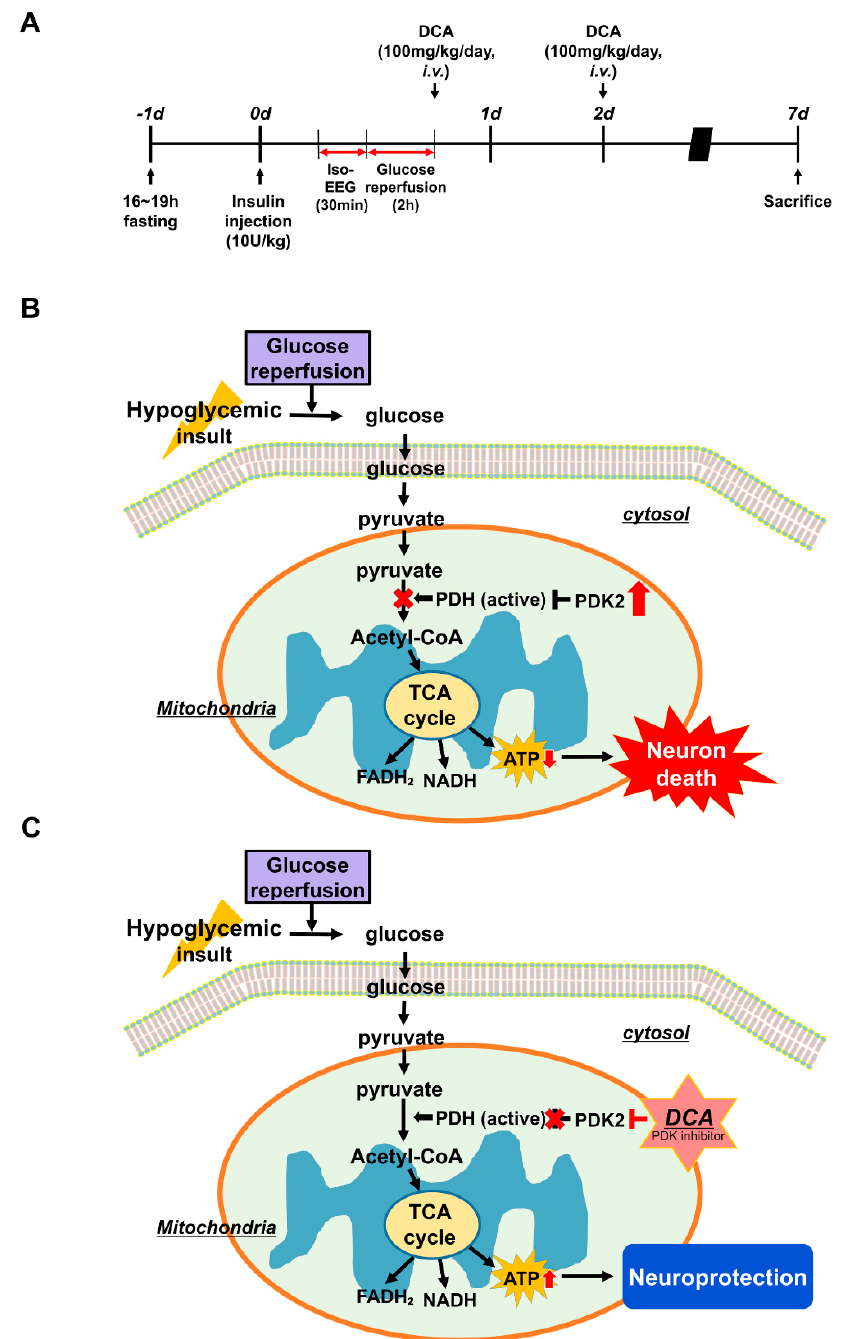
Figure 6. Possible association of PDK2, PDH, DCA, and neuronal death under hypoglycemic conditions. This schematic illustration shows the e ff ects of DCA on the process of hypoglycemia-induced hippocampal neuronal death. ( A ) Experimental timeline. ( B ) Neuronal cell death mechanism caused by hypoglycemia: (1) After hypoglycemia, mitochondria disruption occurs and then PDK2 increase abnormally (2) An abnormally increased PDK2 inhibits the activity of PDH by phosphating PDH (3) The conversion from pyruvate to acetyl-CoA is unsuccessful due to the inhibition of PDH (4) The rate of synthesis of ATP through the TCA cycle significantly reduces. When these conditions dominate, neuronal death is more likely to occur. ( C ) E ff ects of DCA on hypoglycemia-induced neuronal cell death: administration of DCA can inhibit PDK2 and thus prevent hippocampal neuronal death after